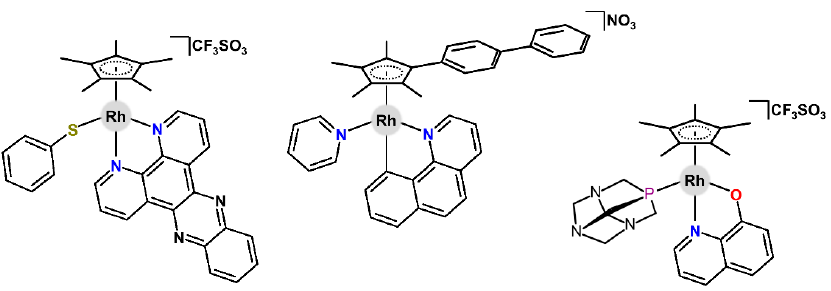
Figure 7. Structural formulas of complexes [Rh( η 5 -Cp*)(dppz)(bzth)]CF 3 SO 3 (left), [Rh( η 5 -Cp*)(py)(bqui)]NO 3 (middle) and [Rh( η 5 -Cp*)(pta)(hq)]CF 3 SO 3 (right), with donor atoms given in blue (N), dark yellow (S), magenta (P) or red